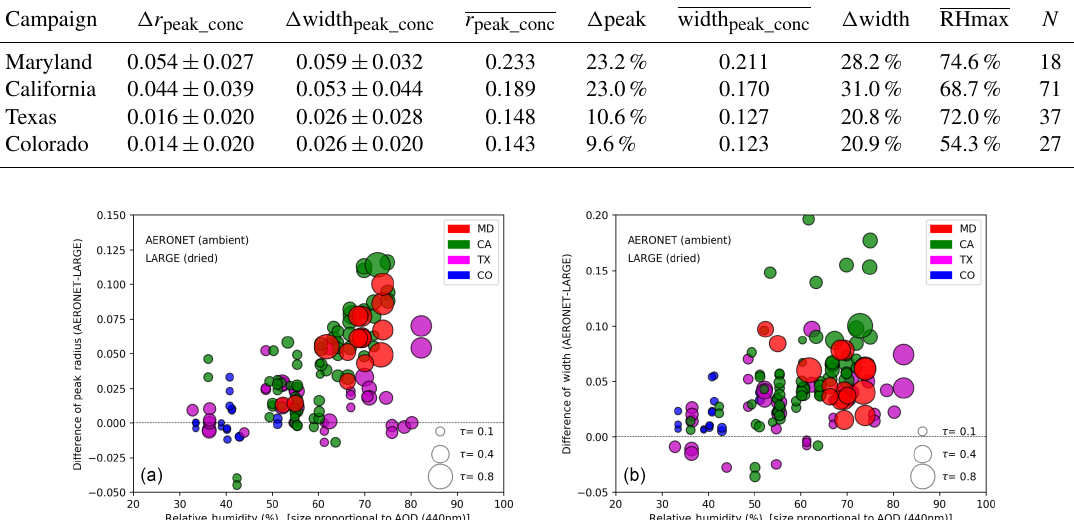
Table 1. Average differences and standard deviations (in µm) in r peak_conc and width peak_conc between AERONET- and LARGE-derived values for all campaign comparisons with no humidification adjustments applied. Also shown are the AERONET average r peak_conc and width peak_conc values for each campaign, AERONET–LARGE differences as a percentage of average values, average profile maximum RH, and number of comparisons.